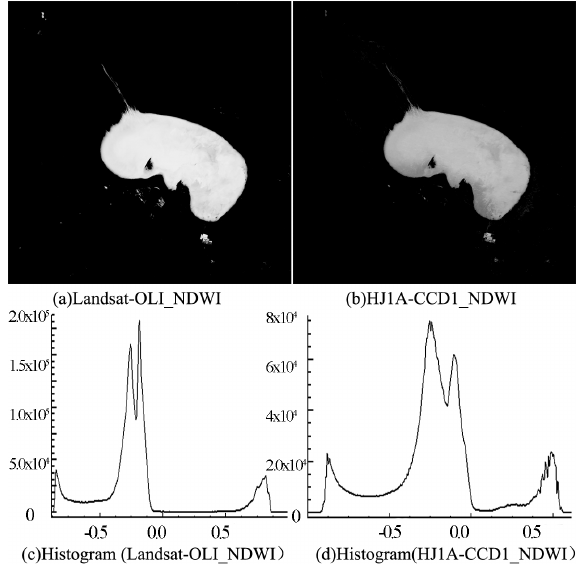
Figure 10. NDWI images and histogram graphs of Landsat-OLI and HJ1A-CCD1